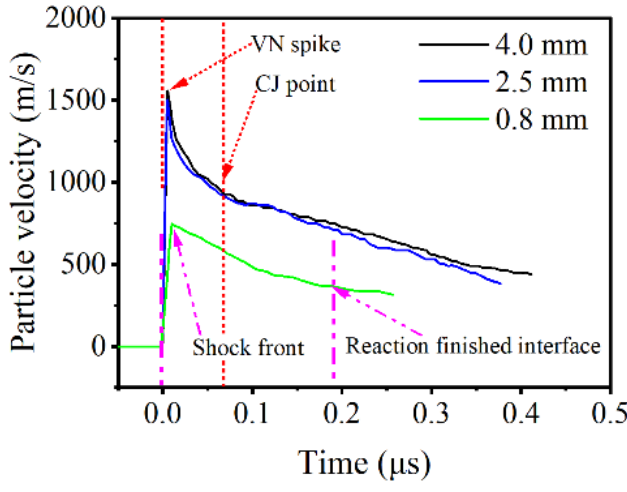
Figure 8. Detailed particle-velocity profiles at the heights of 4.0, 2.5, and 0.8 mm.